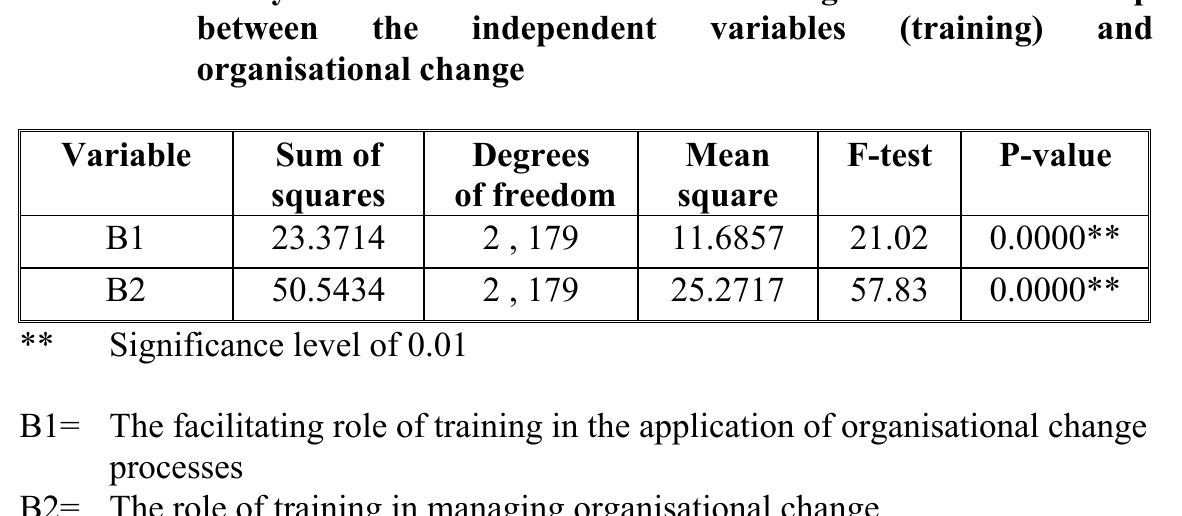
Analysis of variance results to investigate the relationship